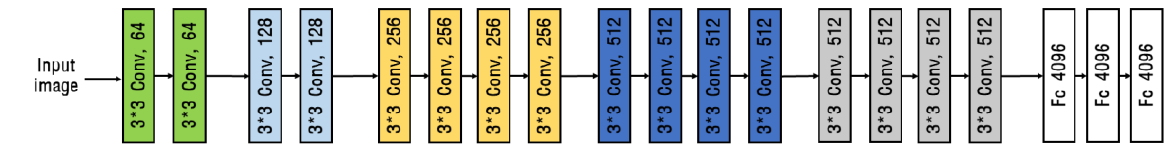
Figure 12. Structure of VGG-19.